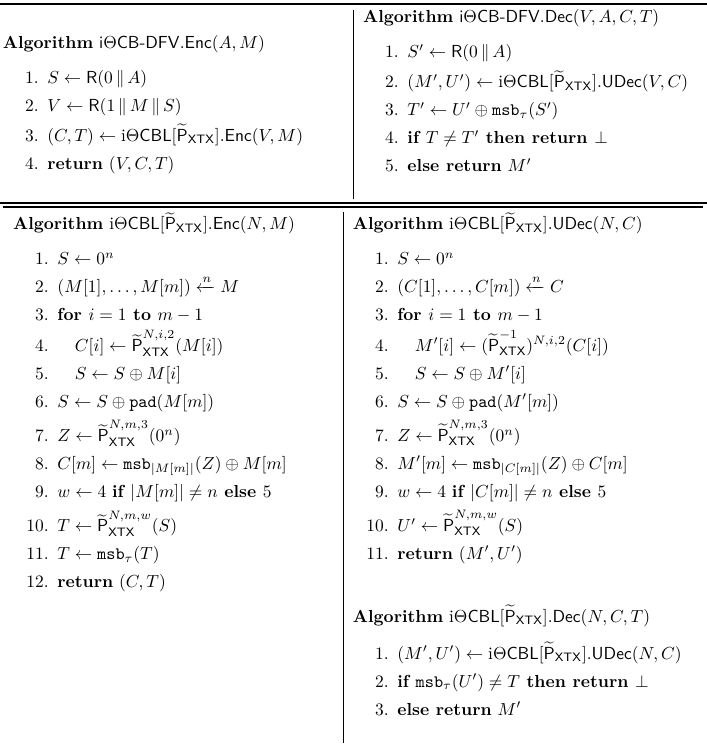
of 3 n -bit effective XTX